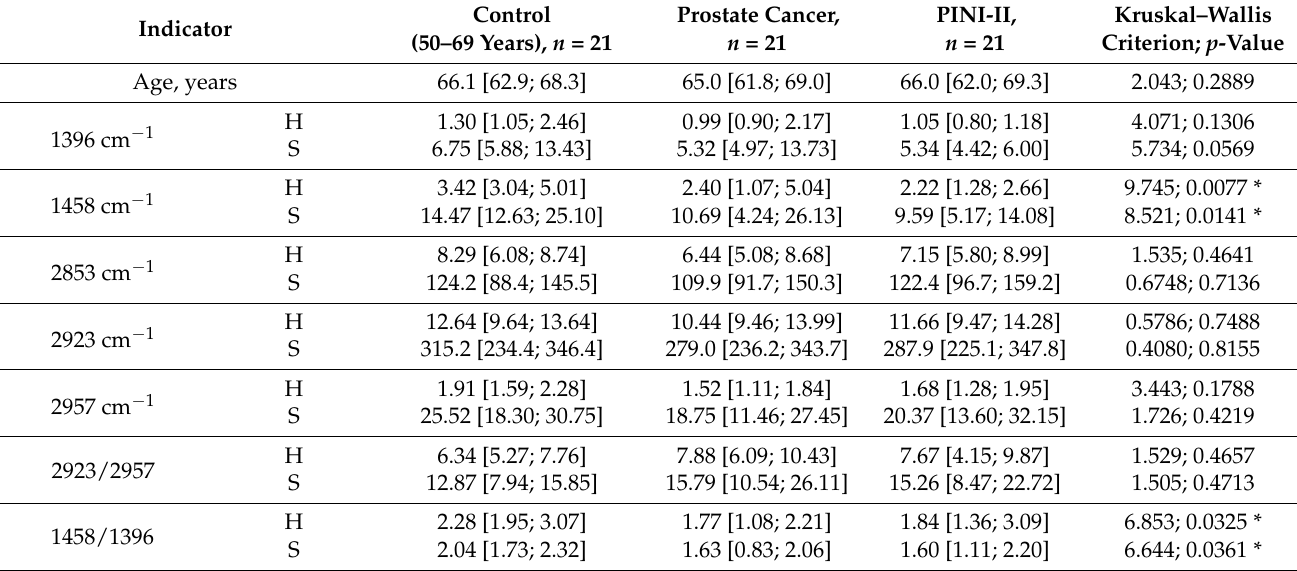
Table 5. Characteristics of salivary IR spectra of patients with prostate